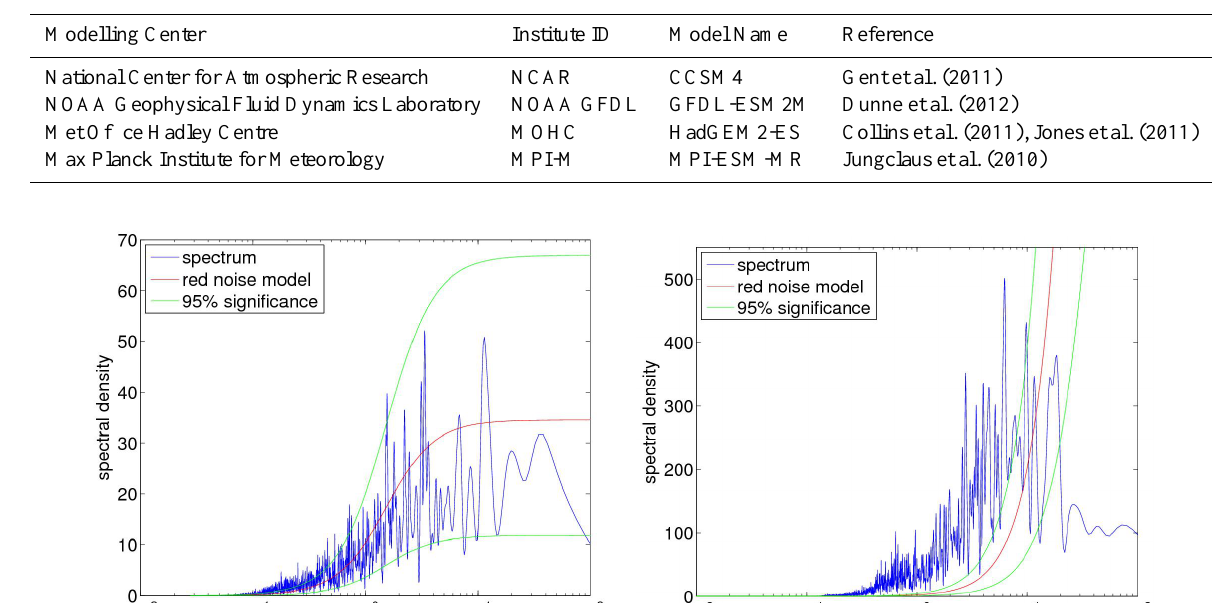
Table 1. Summary of information on the CMIP5 models used in this study.